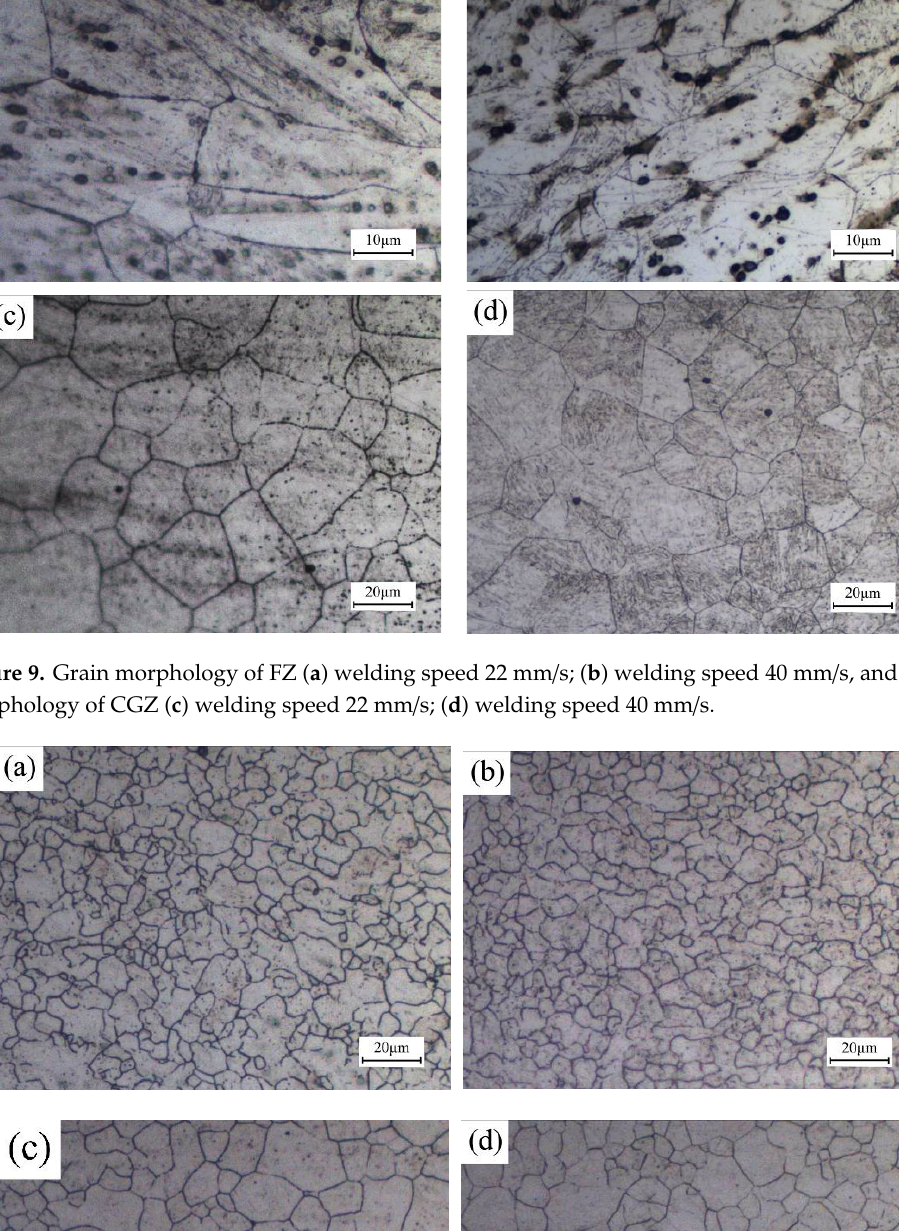
Figure 10. Grain morphology of FZ ( a ) welding speed 22 mm / s; ( b ) welding speed 40 mm / s, and grain morphology of original HAZ ( c ) welding speed 22 mm / s; ( d ) welding speed 40 mm / s after quenching.